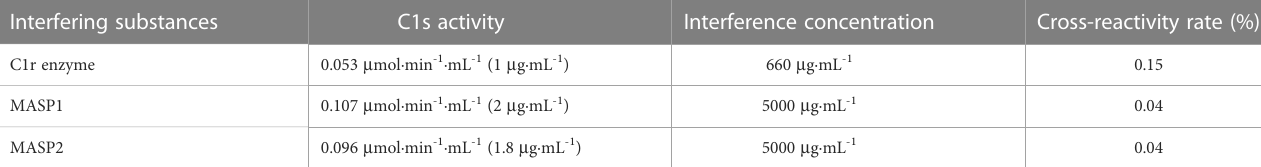
TABLE 4 Cross-reactivity of C1s activity assay.